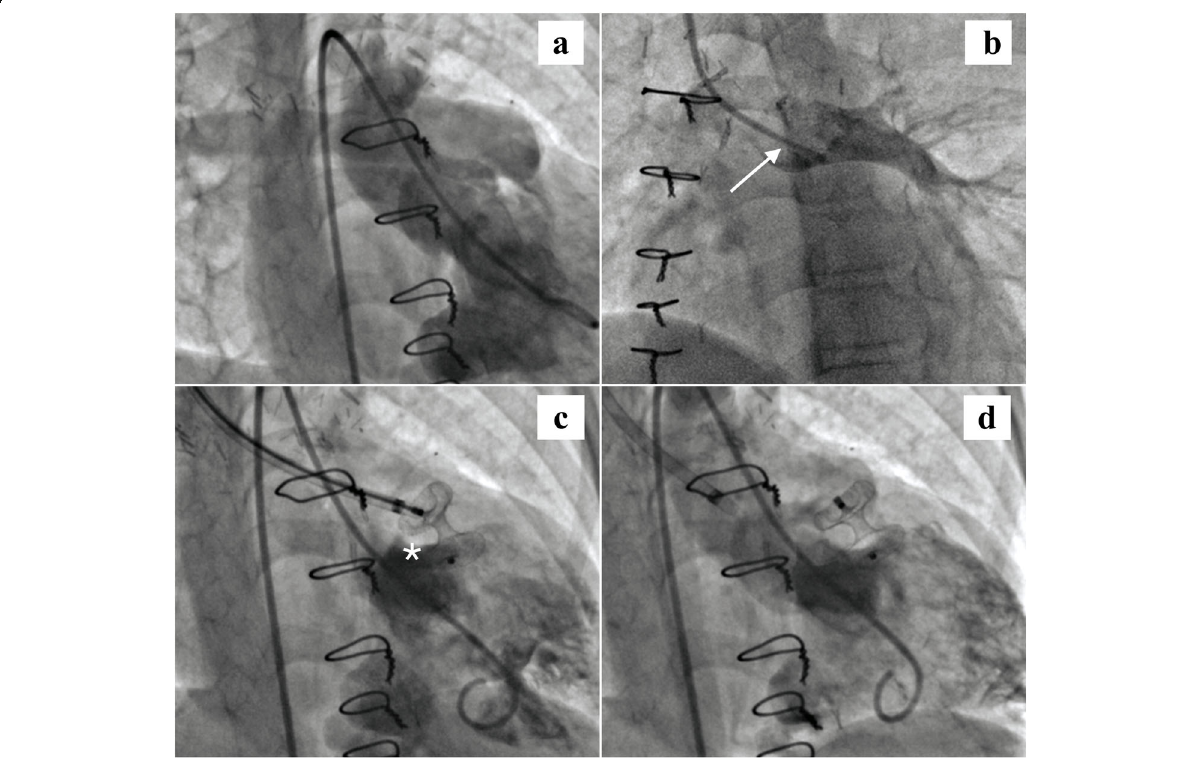
Fig. 1 Antegrade flow occlusion: a Ventricular angiogram shows simultaneous and comparable opacification of both great arteries. b Angiogram in proximal left pulmonary artery with prominent negative clearance (white arrow), secondary to significant antegrade MPA flow. c 10 mm Amplatzer muscular VSD occluder with two disks deployed on either side of the muscular infundibulum (white asterix). d Angiogram after release shows stable device position and complete occlusion of forward